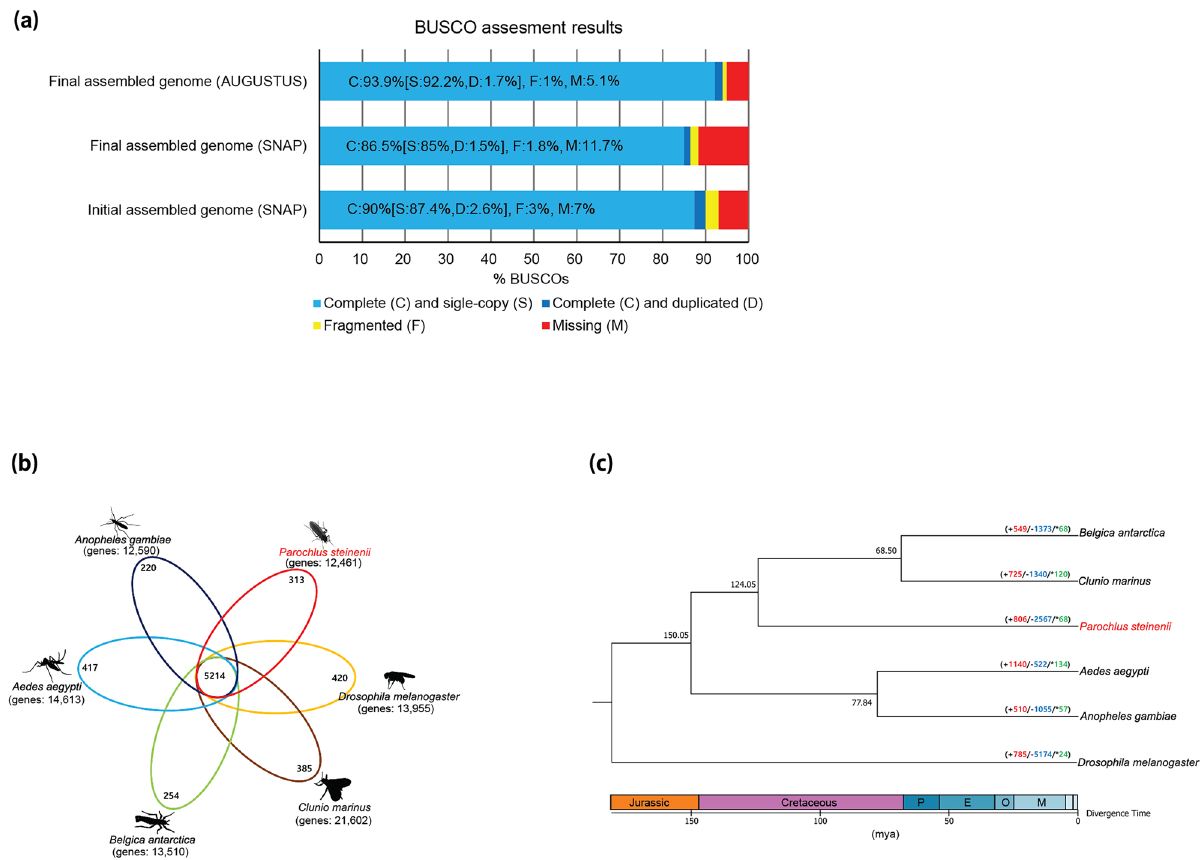
Figure 1. BUSCO assessment of gene set and Comparison of P. steinenii protein-coding genes. ( a ) Completeness assessment of gene sets using BUSCO. The BUSCO dataset of the Insecta odb9 were used to assess the gene sets predicted from the initial assembled genome using SNAP and the gene sets from the final assembled genome using SNAP or AUGUSTUS. ( b ) Venn diagram of orthologous gene families among six dipteran genomes. ( c ) Lineage-specific gene gains and losses in six dipteran genomes. The number of gene gains, losses, and the rapidly evolving gene families were marked in red, blue, and green, respectively. E, M, O, and P denote Eocene, Miocene, Oligocene, and Paleocene, respectively. The aligned sequences of orthologous gene families were used to construct a phylogenetic tree using FastTree (v.2.1.10) and divergence time between species was inferred using